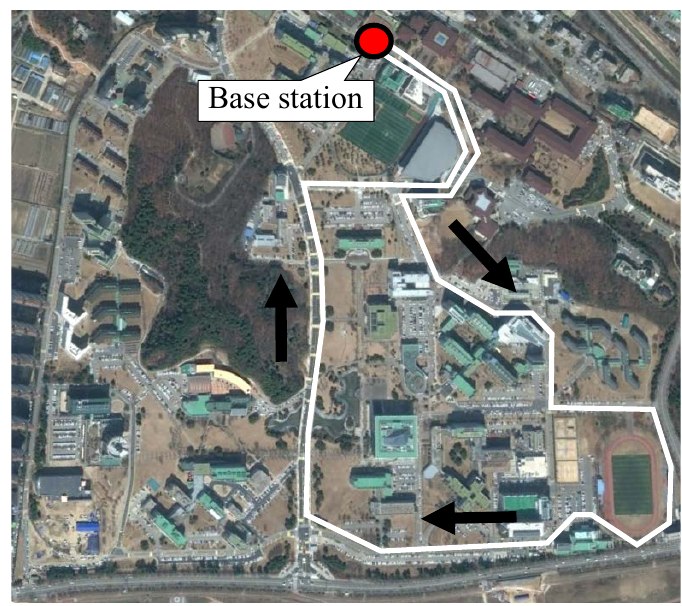
Figure 4. The OLEV shuttle route on the KAIST campus.